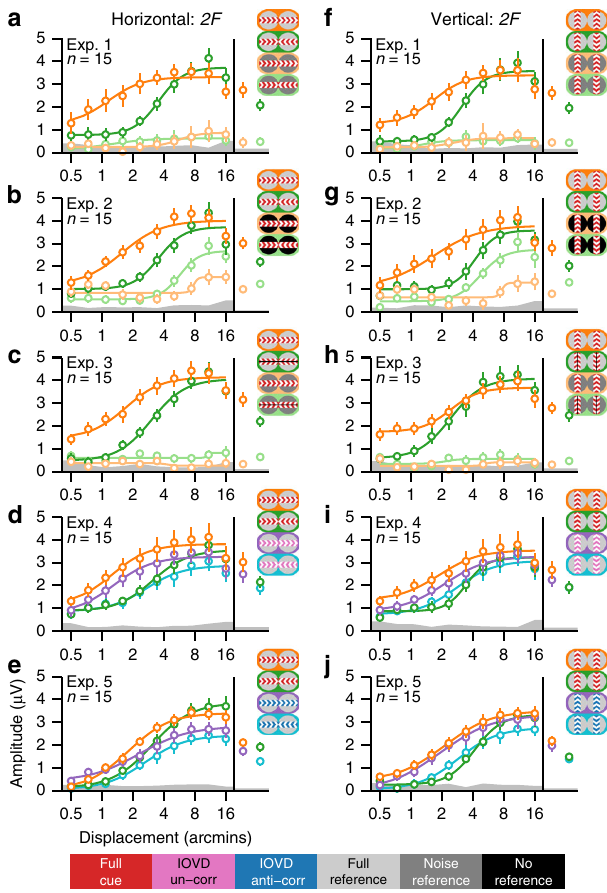
Fig. 2 Adult second harmonic SSVEP response functions. a – e Displacement response functions for the horizontal direction of motion and f – j the vertical direction of motion. Averages across all displacements are shown on the right side of the response functions. Data are from the fi rst reliable component from an RC analysis derived from 2F data from all conditions, separately for each experiment. Scalp topographies for this component were quite similar across experiments (see Supplementary Fig. 2). Each experiment had eight conditions, of which half were horizontal and the rest were vertical. The conditions are represented with icons, consistent with those used in Fig. 1. The central colors indicate the interocular correlation of the test bands, which could be either 100% (full-cue; red), 0% (IOVD- uncorrelated; magenta), or − 100% (IOVD anti-correlated; blue). The fl anking colors indicate the state of the reference bands, which either contained static dots that were 100% correlated between eyes (full- reference; light gray), temporally and interocularly uncorrelated dots (noise-reference; dark gray), or no dots (no-reference; black). The meaning of each color is shown in the legend in the bottom of the fi gure. Smooth curves are Naka – Rushton function fi ts to the data. The gray bands at the bottom of the plots indicate the background EEG noise level, with the top of the band indicating the average noise level across two neighboring side bands, averaged across conditions. Error bars plot ±1 standard error of the mean (SEM) ( 2F /4 Hz) being the largest (see Fig. 2 for 2F and Supplementary Fig. 1 for 4F /8 Hz response functions). In the fi rst condition of Experiment 1, the test bands were moving in-phase and were fl anked by reference bands containing static dots (full-cue/full-reference; Fig. 1a), and the SSVEP amplitude is a saturating function of horizontal displacement (Fig. 2a, dark orange). This response function is well described by